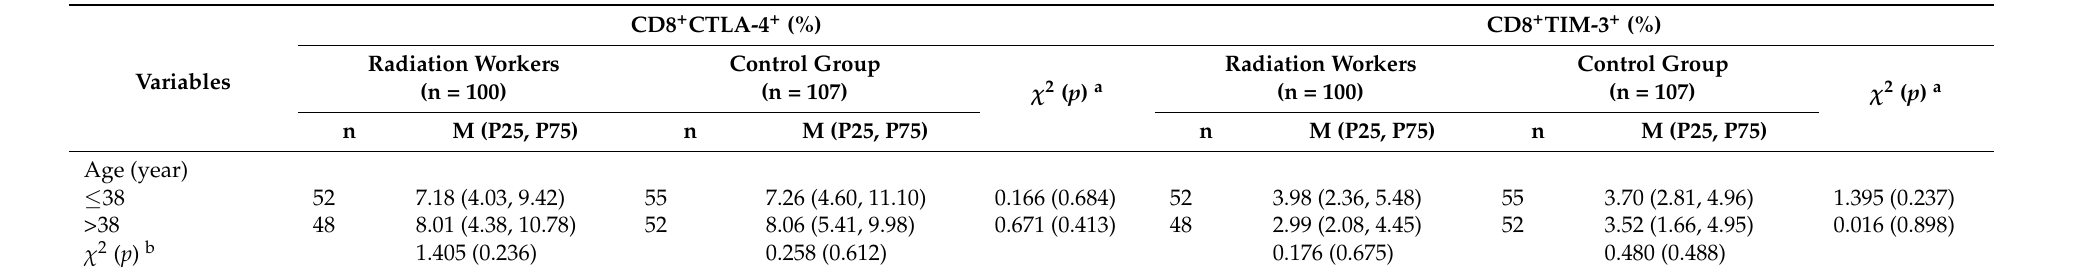
Table 5. Relationship between demographic characteristics and the expression of CTLA-4 and TIM-3 in